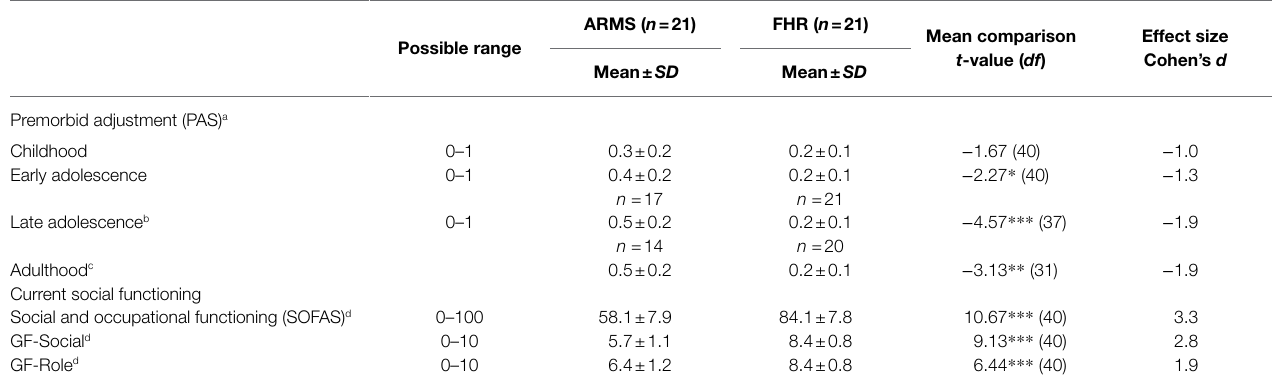
TABLE 4 | Description and comparison of premorbid and current functioning between ARMS and FHR groups.